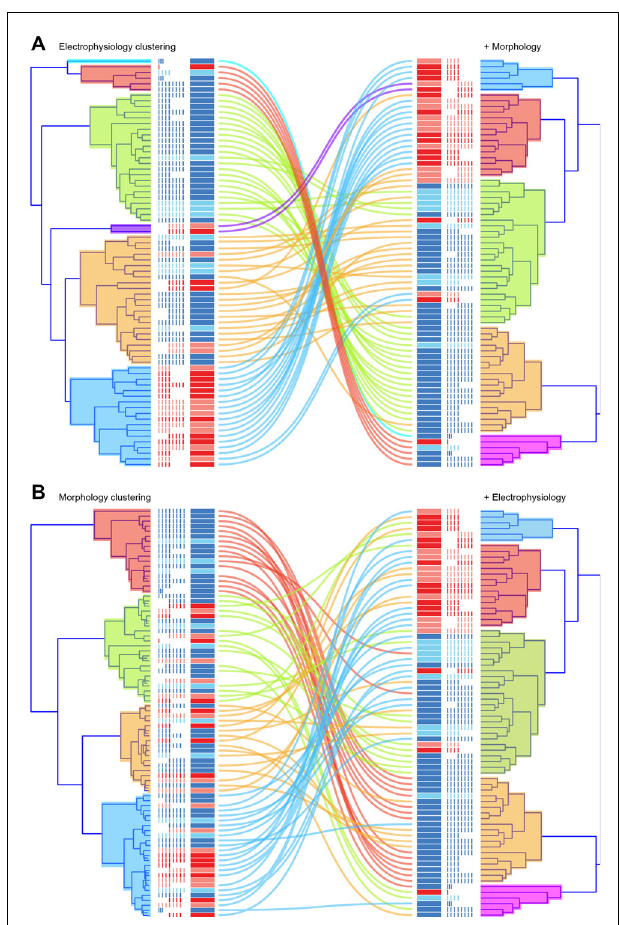
FIGURE 9 | Correlation of cluster membership across clustering approaches. The figure compares individual cell cluster membership when clustering is based on electrophysiological ( A , upper left) or morphological data ( B , lower left), and when both datasets are combined (right for both A,B ). Corresponding dendrograms are presented side-by-side, with lines denoting cell location in clustering (left vs. right). When the path of a colored line remains close to others from its original cluster the clusters are shared: electrophysiological vs. electrophysiological plus morphological clustering (A) ; or morphological vs. morphological plus electrophysiological clustering (B) . Note cluster membership remains similar in (A) but diversifies more dramatically in ( B ; i.e., there is more mixing of the colored